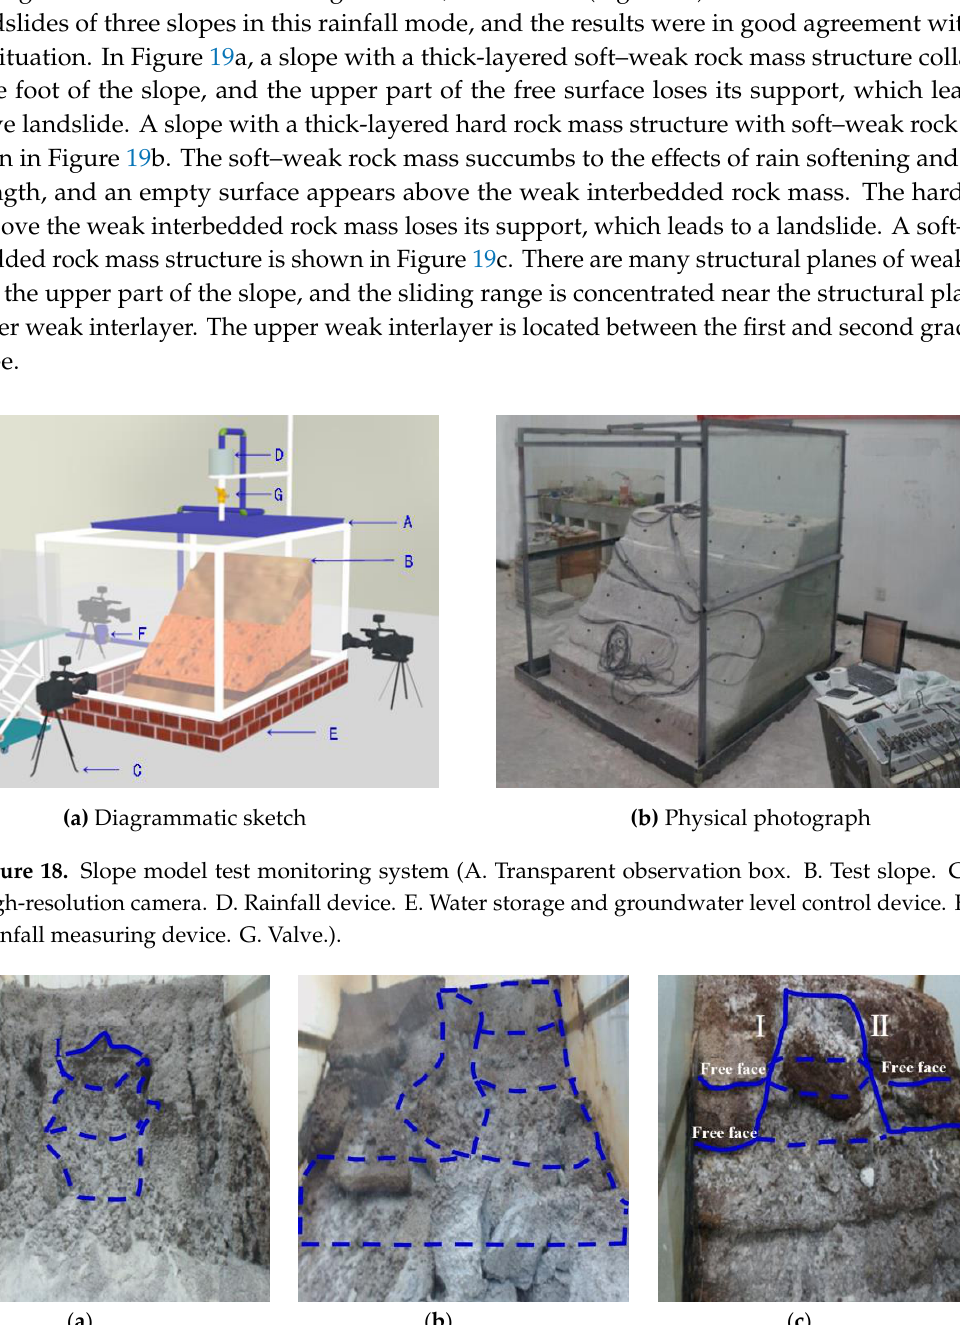
Figure 19. Simulated slope failure modes: ( a ) slope with thick-layered soft-weak rock mass structure. ( b ) Thick-layered hard rock mass structure with soft-weak rock mass. ( c ) Soft-hard inter-bedded rock mass structure.